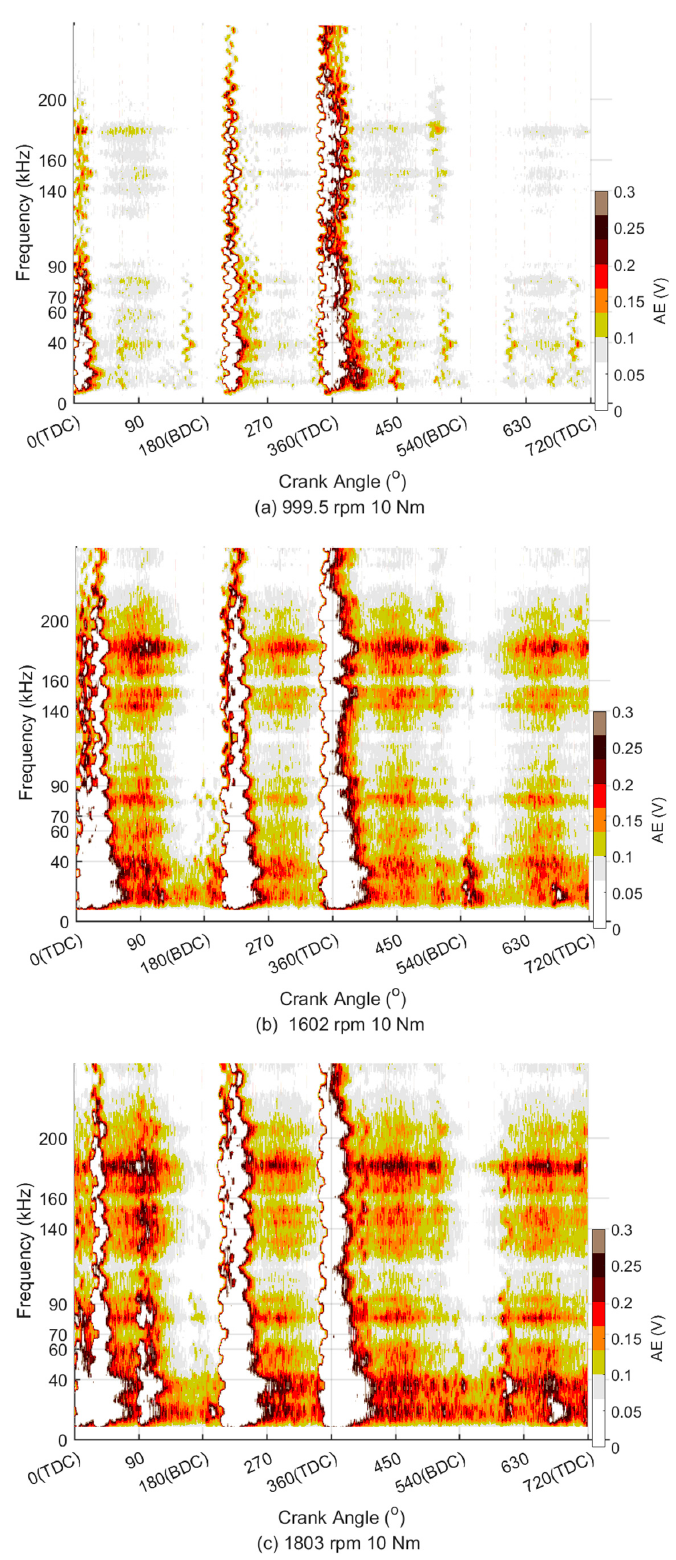
Figure 6. Wavelet packet transform (WPT) spectrum of raw AE for 10W30 oil by db4 wavelet: ( a ) 999.5 rpm 10 Nm; ( b ) 1602 rpm 10 Nm; ( c ) 1803 rpm 10 Nm.